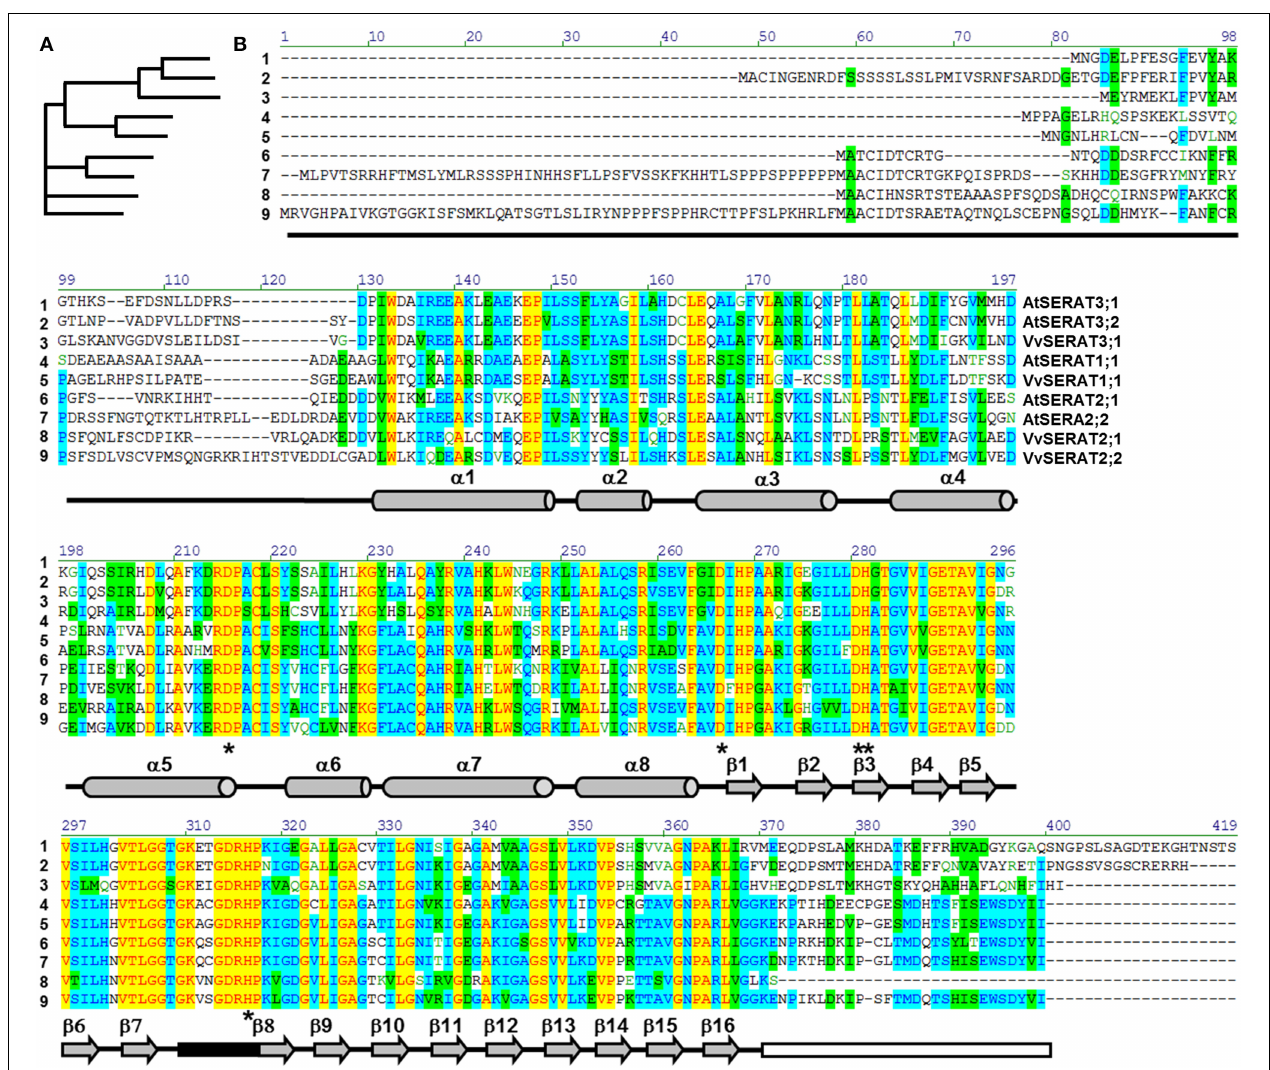
FIGURE 1 | Comparison of SERAT protein families in grapevine and Arabidopsis. Full length protein sequences of biochemically verified SERAT proteins from Arabidopsis and grapevine were compared with the AlignX tool of the Vector NTI Advance 9.1.0 software suite (Invitrogen, Germany). (A) , Guide tree. (B) , Protein-sequence alignment, Color code indicates degree of similarity (yellow, font red: identical; cyan, font blue: conservative; green, font